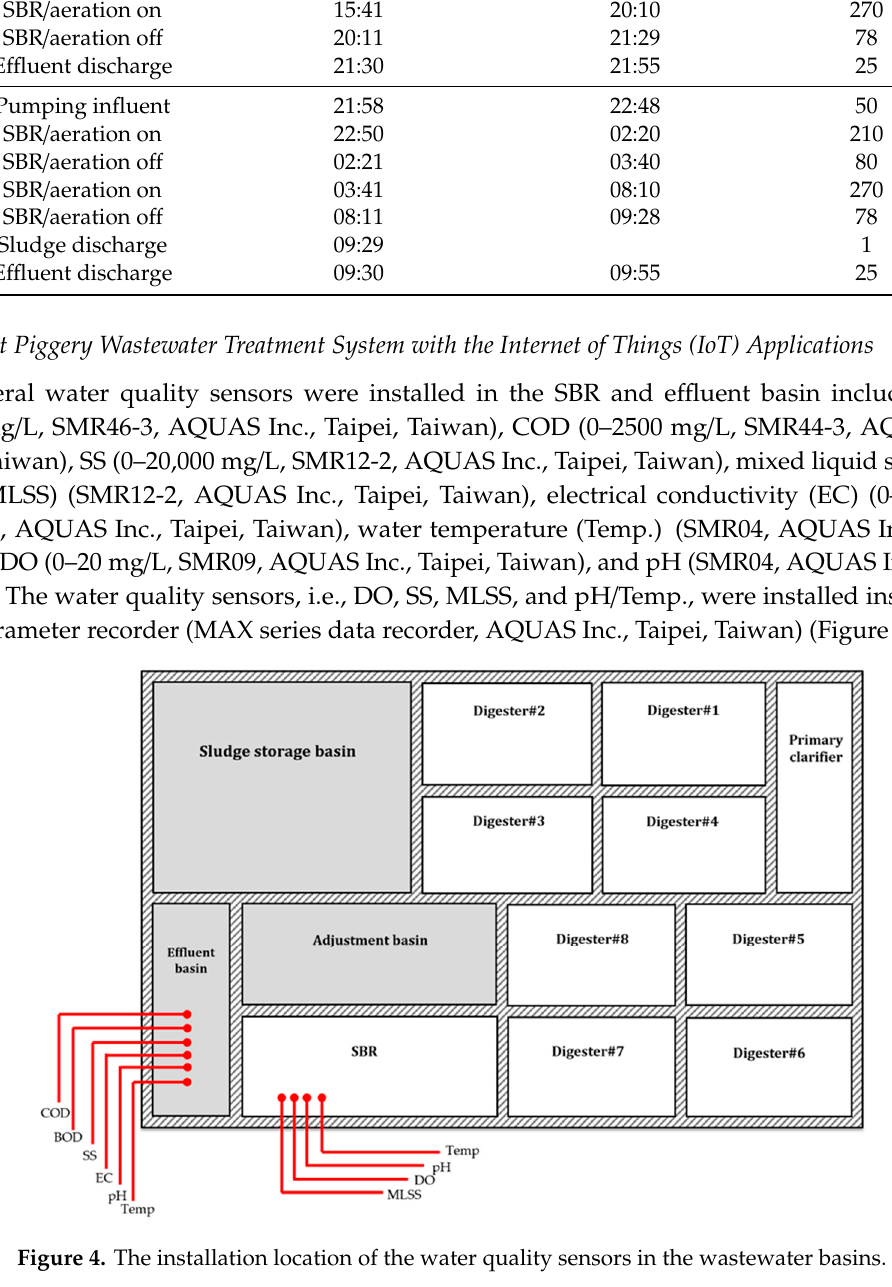
Table 1. The operation mode of the SBR system on site.